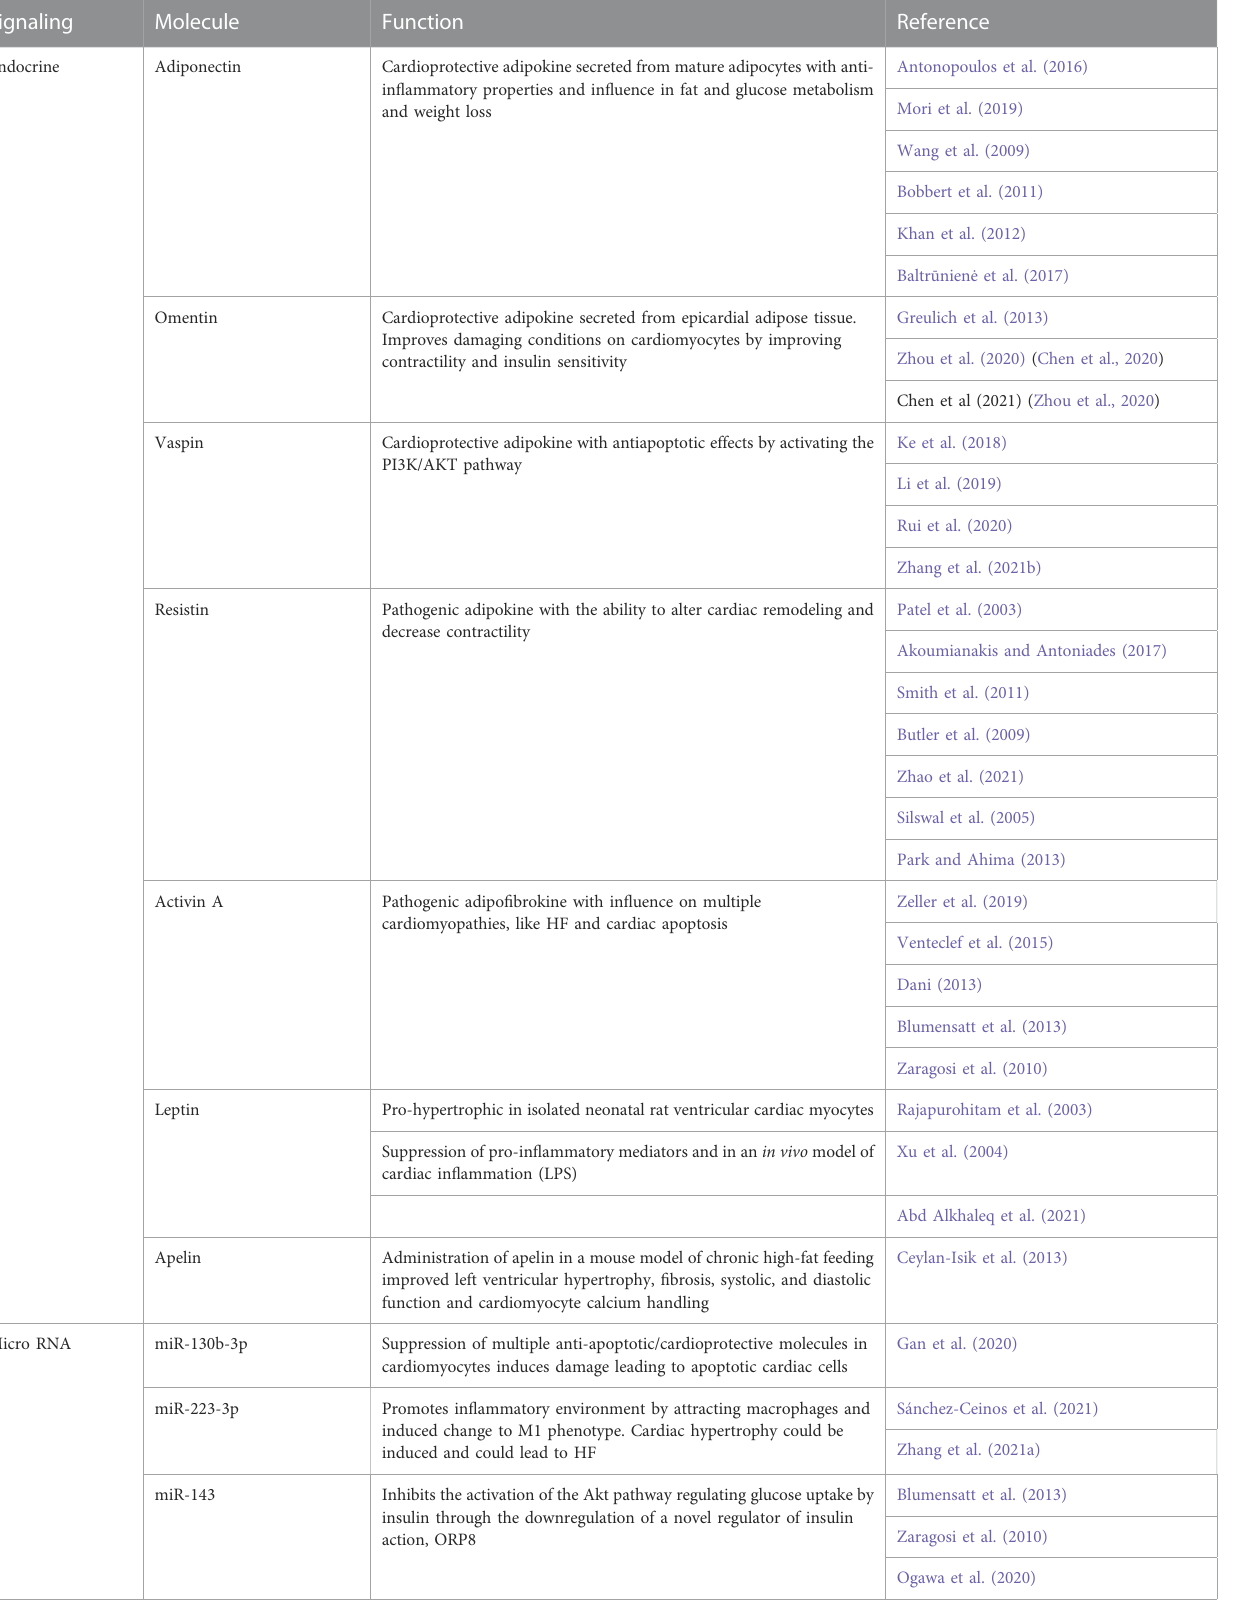
TABLE 1 Overview of the literature describing the molecular basis of fat – heart